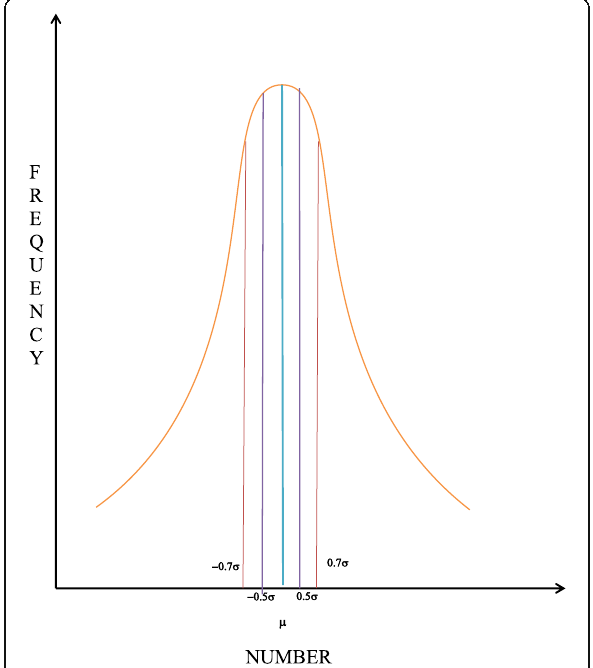
Fig. 3 Depiction of second level of thresholds for TTSD algorithm. Legends: σ , standard deviation; μ ,